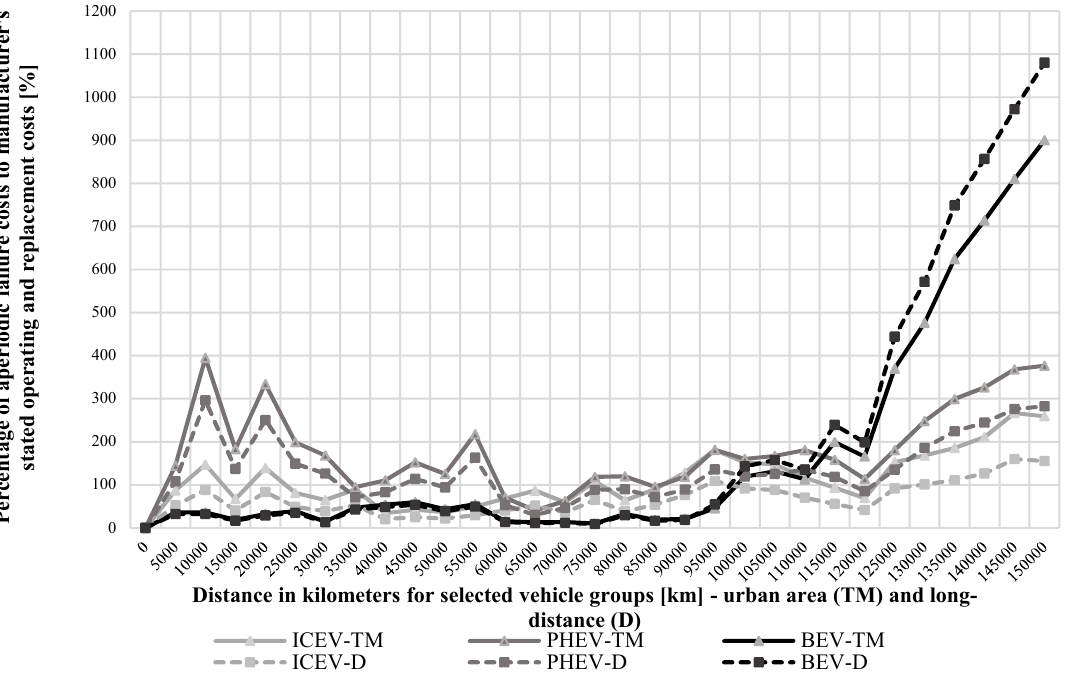
Figure 13. Percentage of aperiodic failures cost in the entire balance of vehicle operating costs resulting from periodic inspections and replacement of components recommended by the manufacturer—a high-class limousine.